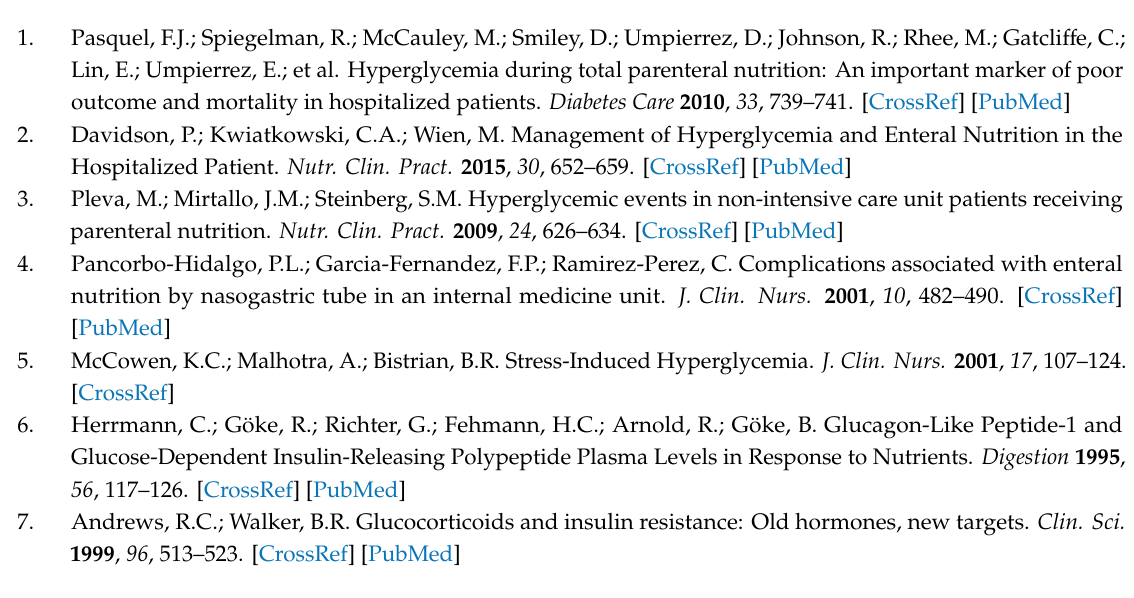
Figure S1: Quality assessment of clinical trials according to modified Cochrane Risk of Bias tool [30]. Table S1: Table S5: PRISMA 2009 checklist [28], Table S6: MOOSE checklist [29]. Author Contributions: Conceptualization and methodology, L.B.; design and conduction of the search: C.I.L. and L.B.; writing—original draft preparation; C.I.L. and L.B.; writing—reviewing and editing: C.I.L., P.C.,